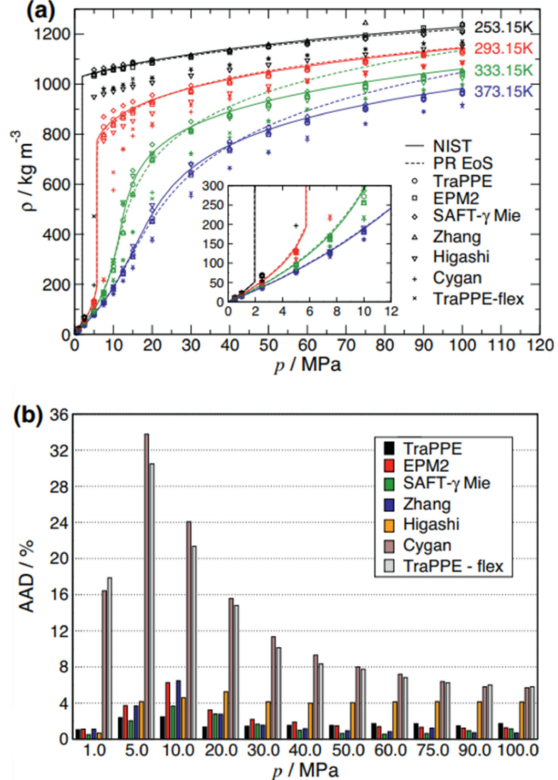
Figure 6. Force fields used for CO 2 studies: ( a ) Densities according to T = 253, 293, 333, and 373 (K). The line is smoothed experimental data from NIST, the dashed lines the Peng–Robinson EoS (equation of state), and the symbols are MD predictions by TraPPE, EPM2, SAFT-Mie, Zhang, Higashi, Cygan, and TraPPE-flex force fields. ( b ) Average aberration from experimental results. (For in-depth interpretation of these data, readers are referred to Aimoli et al. paper